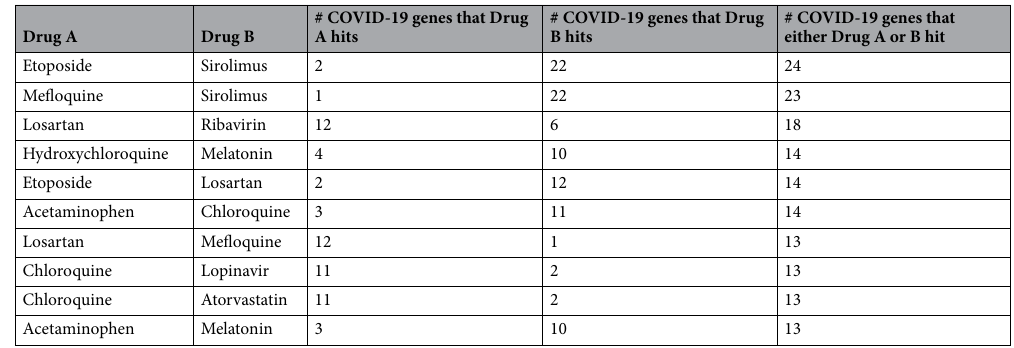
Table 4. Drug combinations that satisfy the complementary exposure pattern from the top 30 drugs 43